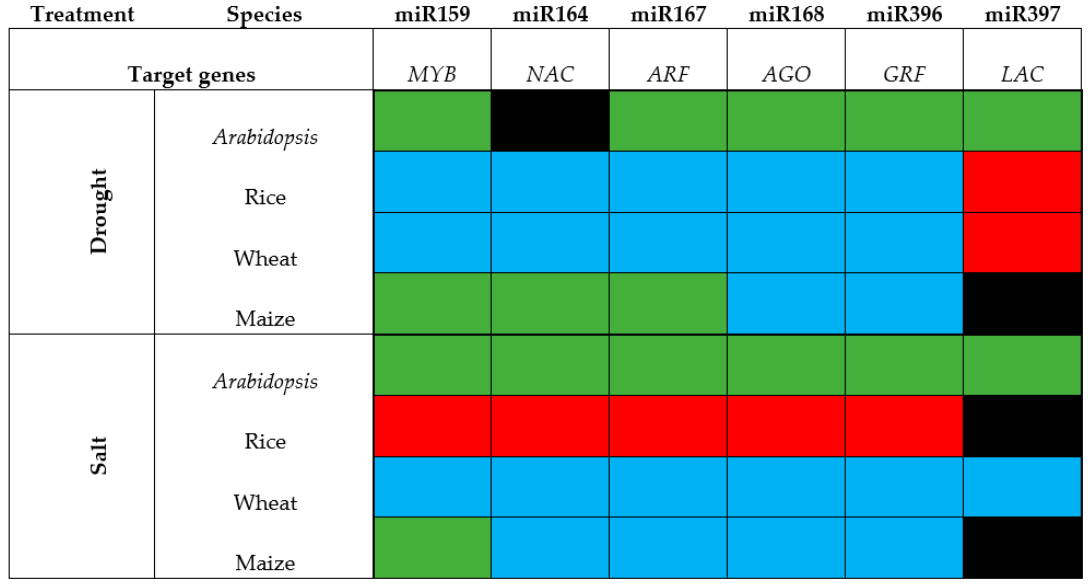
Figure 1. MicroRNA accumulation trends in Arabidopsis, rice, wheat, and maize in response to drought and salt stress. The accumulation of miRNAs, miR159, miR164, miR167, miR168, miR396 and miR397, in response to drought and salt stress in Arabidopsis , rice, wheat and maize. Green shaded boxes indicate elevated miRNA abundance in response to the applied stress. Red shaded boxes indicate reduced miRNA abundance in response to the applied stress. Blue shaded boxes indicate that miRNA abundance has been reported by different studies to have an opposing abundance trend post exposure to the same stress. Black shaded boxes identify miRNAs for which data is currently lacking in the assessed species. The gene family to which the target gene(s) of each of the 6 selected miRNAs belongs is indicated in the line immediately below the name of the targeting miRNA at the top of each column, more specifically MYB ( MYELOBLASTOSIS ), NAC ( NAM/ATAF/CUC2 ), ARF ( AUXIN RESPONSE FACTOR ), AGO ( ARGONAUTE ), GRF ( GROWTH REGULATING FACTOR ) and LAC ( LACCASE ).